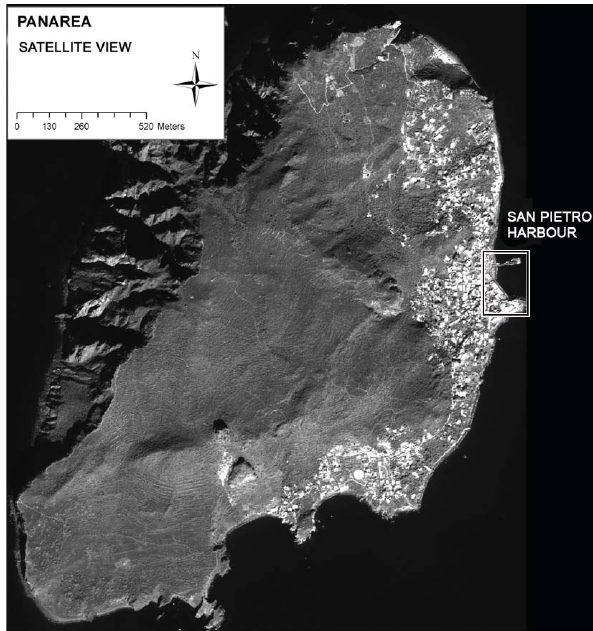
Fig. 3. A “Worldview” satellite image of Panarea Island. The frame indicates the harbour of San Pietro, where five buildings were inun- dated during the 2002 tsunami. Given the small flooded area, the inundation line was not recorded on Panarea